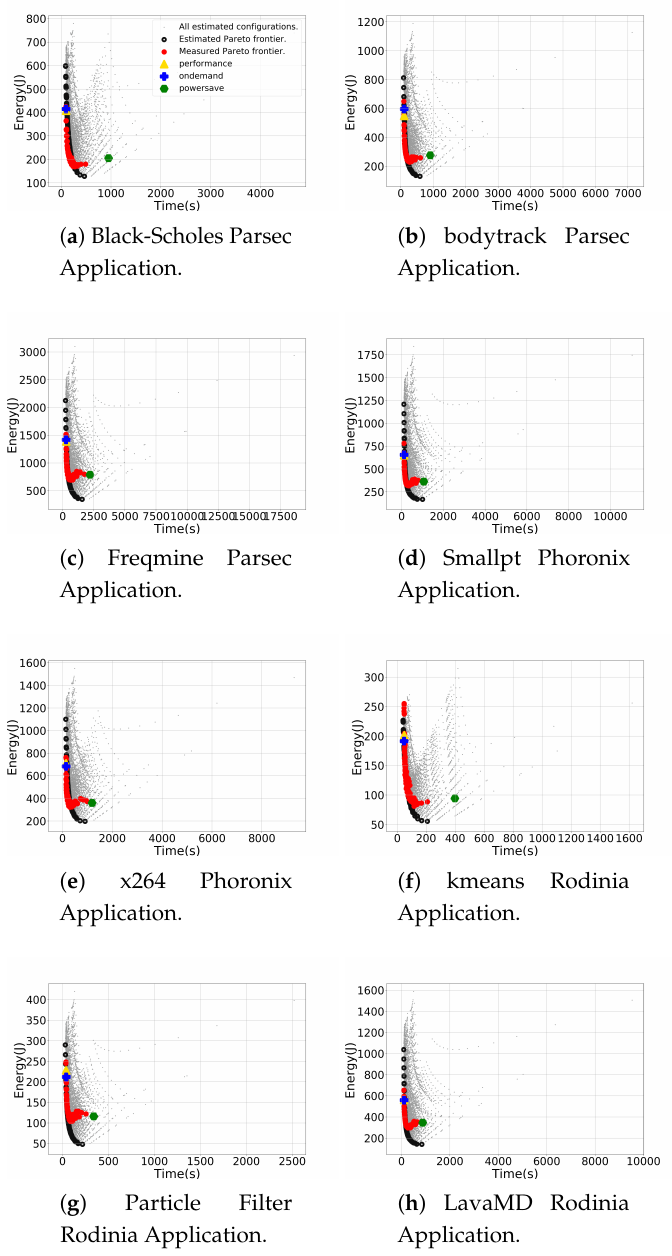
Figure 4. Estimated and measured Pareto frontier compared with the default governors, and all possible modeled